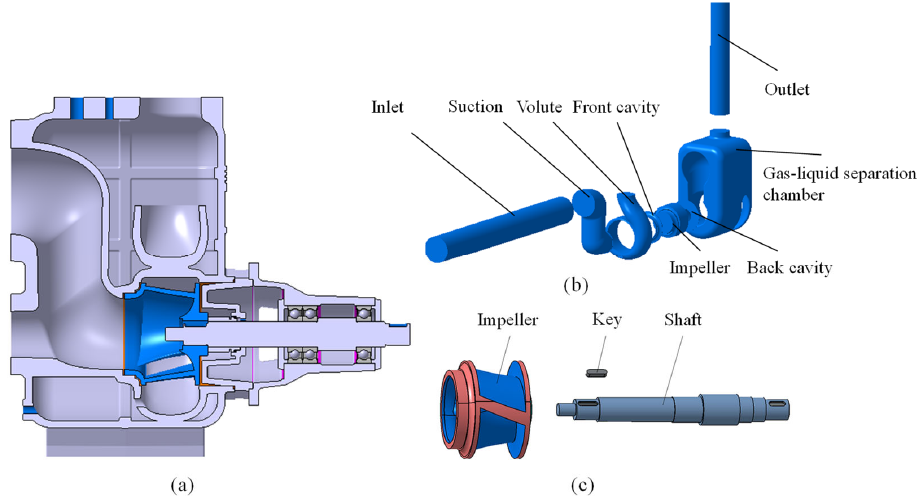
Figure 1. Sketch of pump model: ( a ) Section drawing of pump model; ( b ) fluid domain; ( c ) rotor system.